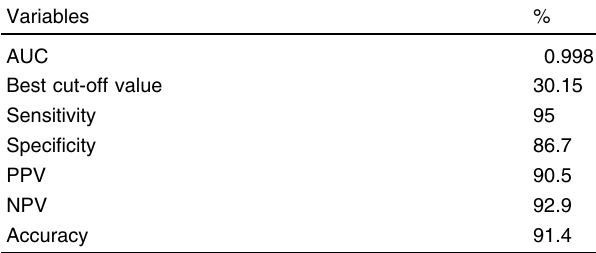
Table 9 Percentage positivity of different parameters in the diagnosis of pulmonary tuberculosis